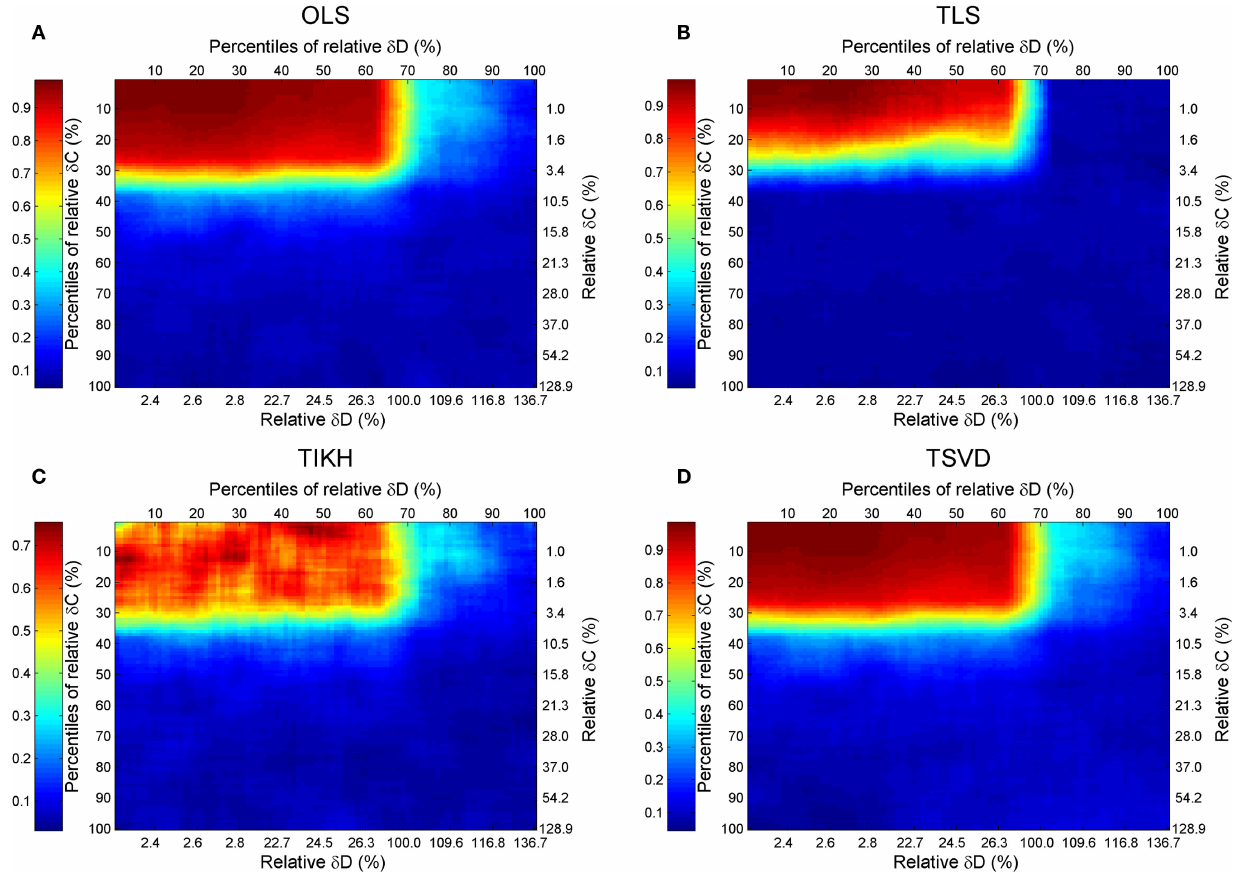
Frontiers in Bioengineering and Biotechnology |